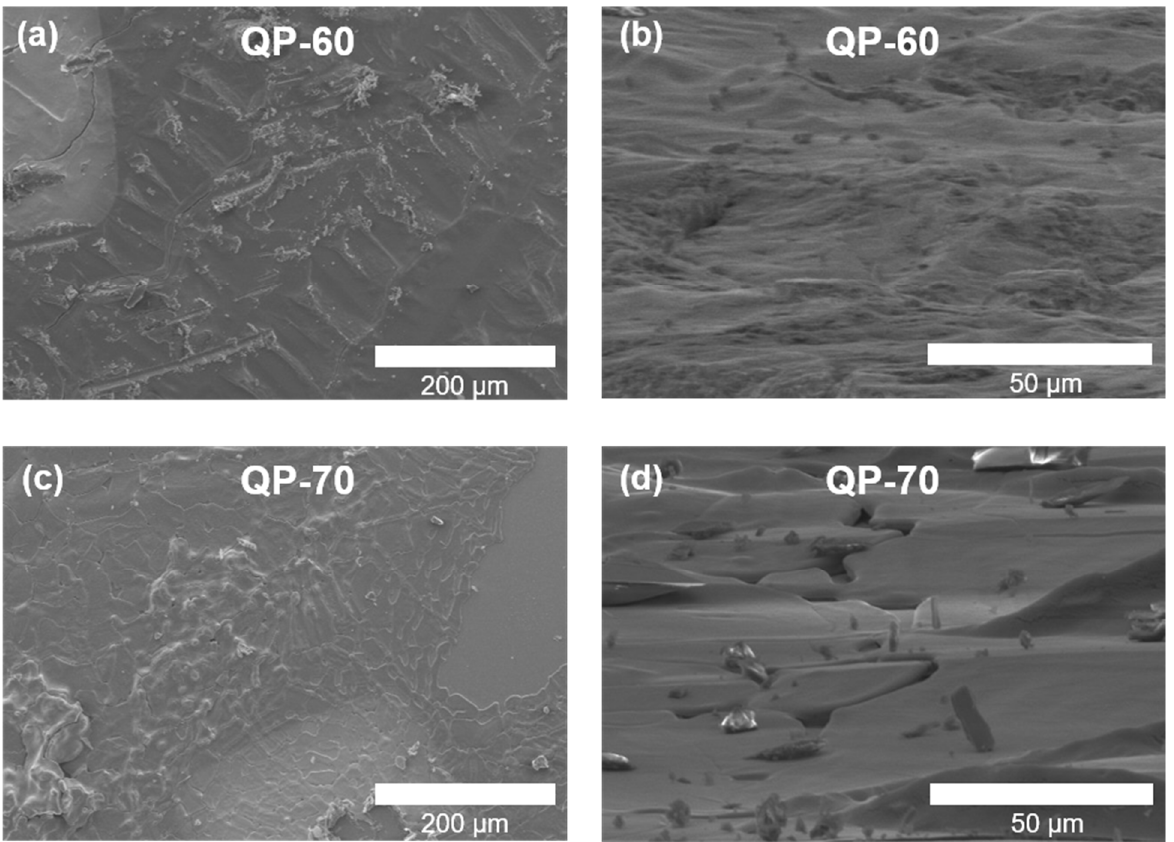
Materials 2021 , 14 , x FOR PEER REVIEW Figure 2. SEM images of ( a , b ) QP-60 and ( c , d ) QP-70 thin films. Figure 2. SEM images of ( a , b ) QP-60 and ( c , d ) QP-70 thin films.